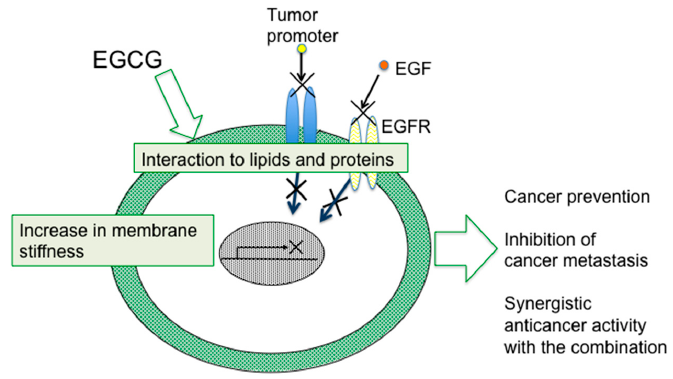
Figure 4. Schematic illustration of biophysical understanding of multifunctions of EGCG in relation to “sealing effects of EGCG”.